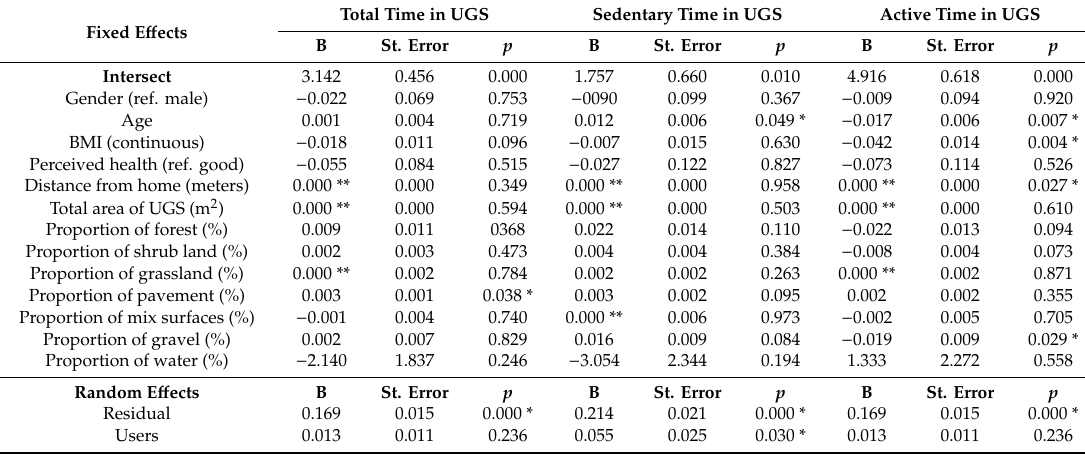
Table 4. Mixed-e ff ects linear regression a,b